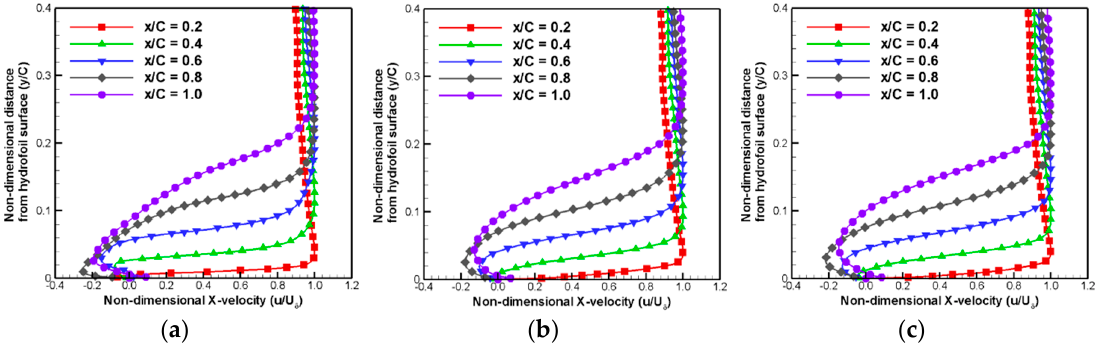
Figure 15. Time-averaged x-directional velocity distribution at five stream-wise locations: ( a ) viscous lagging; ( b ) full viscous; and ( c ) thin-layer cases.